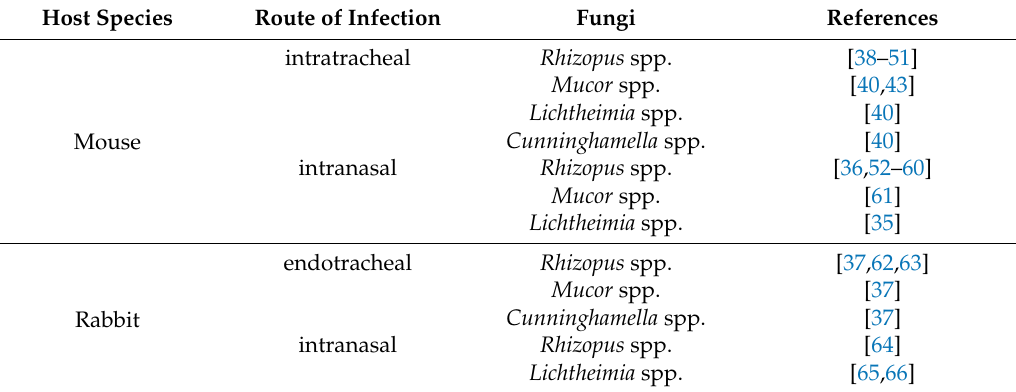
Table 1. The selected studies using pulmonary models of mucormycosis 1